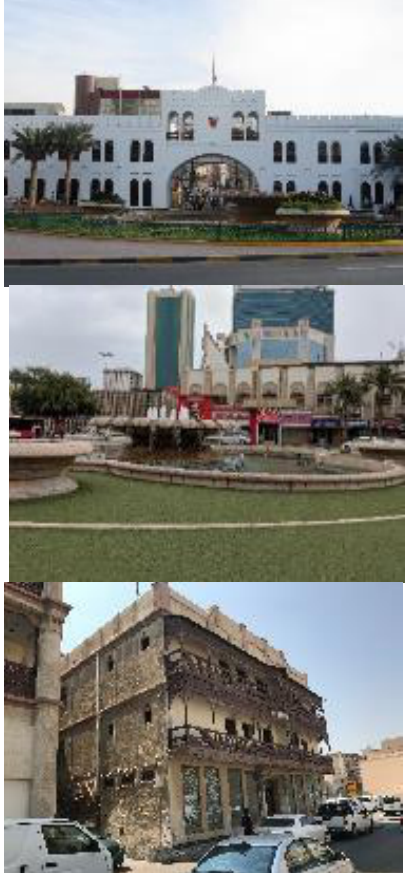
Figure 8. The most famous buildings in the study area.